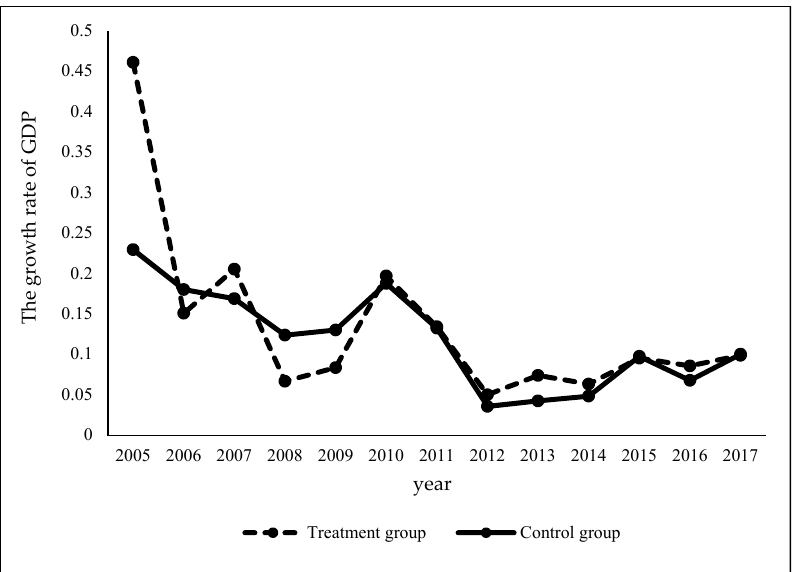
Figure A3. The homogeneity hypothesis of economic growth between the treatment group and con-